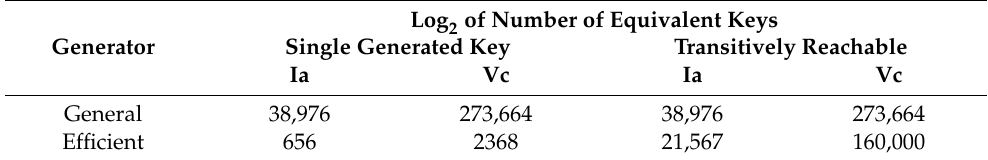
Table 1. Summary of equivalent key